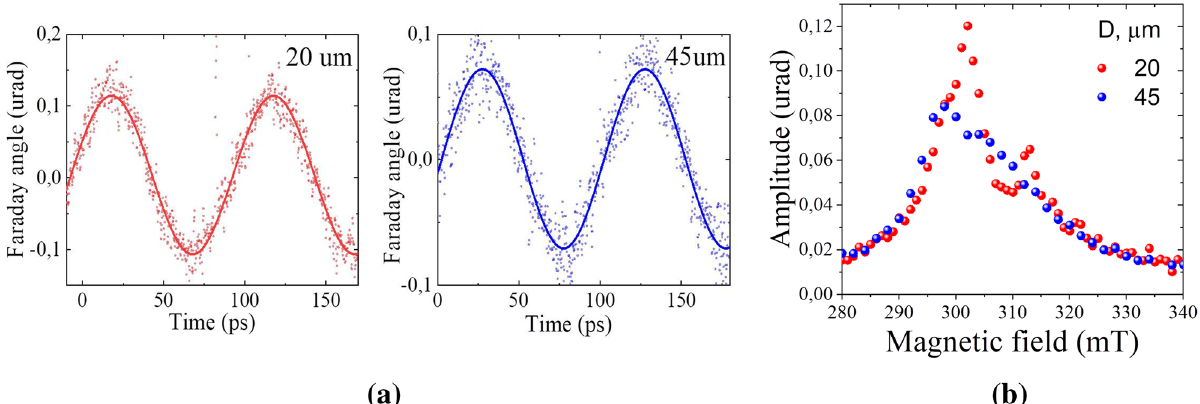
Figure 3. ( a ) Magnetization precession excited in the 20 μm and 45 μm disks when the pump beam center coincides with the microdisk center. The external magnetic field is 3.01 kOe. ( b ) Dependence of the magnetization precession amplitude on the magnetic field for the 20 μm and 45 μm disks. The laser pump fluence is 5.2 µJ/cm 2